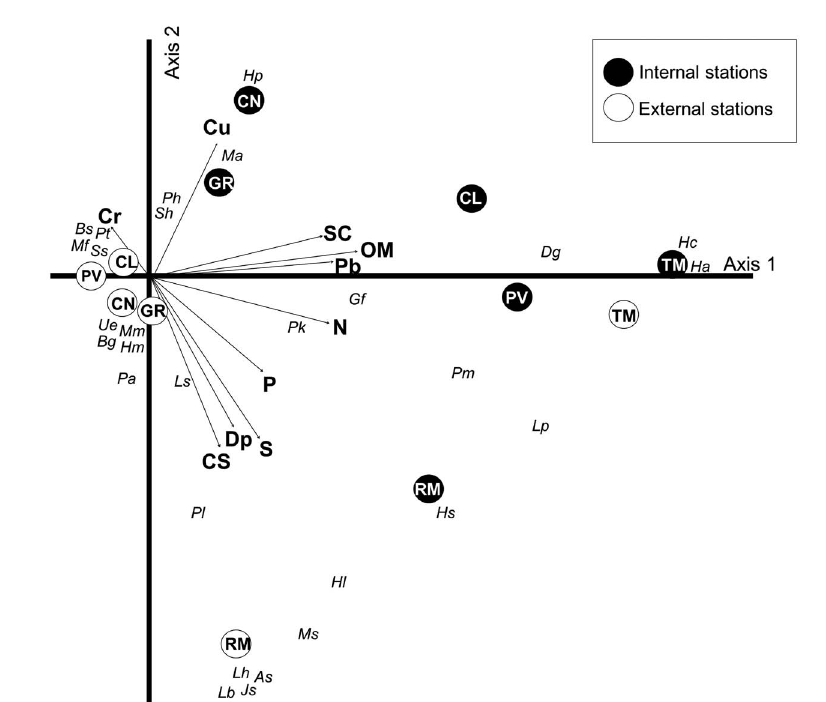
4. – Graphic representation of the stations, species and environmental variables with respect to the first two axes of the canonical cor- respondence analysis (CCA). SC (silt and clay), CS (coarse sand), OM (organic matter), Dp (depth), As ( Ampelisca sp.), Bs ( Bathyporeia sp.), Bg ( Bathyporeia guilliamsoniana ), Dg ( Deflexilodes griseus ), Gf ( Gammarella fucicola ), Ha ( Harpinia antennaria ), Hc ( Harpinia crenulata ), Hp ( Hippomedon massiliensis ), Hl ( Harpinia ala ), Hs ( Harpinia sp.), Js ( Jassa sp.), Lb ( Lembos sp.), Lh ( Leptocheirus hirsutimanus ), Lp ( Leptocheirus pectinatus ), Ls ( Leucothoe sp.), Ma ( Microdeutopus algicola ), Mf ( Metaphoxus fultoni ), Mm ( Megaluropus monasteriensis ), Ms (cf. Melita sp.), Pa ( Pontocrates arenarius ), Ph ( Photis longipes ), Pk , ( Pseudolirius kroyeri ), Pl ( Perioculodes longimanus ), Pm ( Phtisica